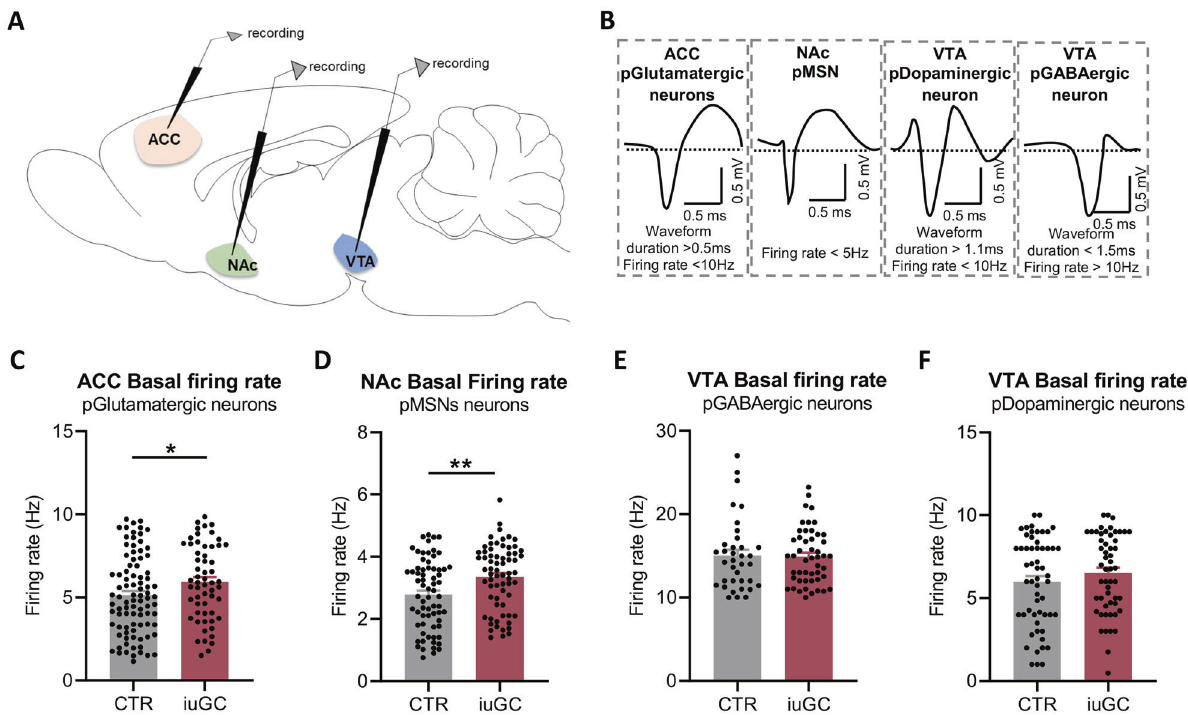
Fig. 3 iuGC exposure hampers neuronal basal activity of ACC and NAc. A Schematic representation of electrophysiological recordings of ACC, NAc, and VTA. B ACC neurons were separated according to fi ring rate and waveform characteristics: putative glutamatergic neurons; NAc neurons were separated according to fi ring rate and waveform characteristics putative medium spiny neurons (pMSNs); VTA neurons were classi fi ed as: putative dopaminergic neurons or putative GABAergic neurons. C The basal fi ring rate of the ACC is signi fi cantly different between groups, with iuGC rats presenting a hyperactivation of putative glutamatergic neurons. n CTR = 4 animals/90 cells (12 – 32 cells/animal); n iuGC = 4 animals/58 cells (13 – 18 cells/animal). D iuGC group has an hyperactivation of putative MSNs of the NAc; n CTR = 4 animals/68 cells (8 – 16 cells/animal); n iuGC = 5 animals/67 cells (6 – 20 cells/animal). The basal activity of the VTA of E putative GABAergic ( n CTR = 4 animals/56 cells (2 – 12 cells/animal); n iuGC = 4 animals/54 cells (2 – 15 cells/animal)) and F putative dopaminergic neurons ( n CTR = 5 animals/36 cells (2 – 12 cells/animal); n iuGC = 5 animals/55 cells (2 – 12 cells/animal)) is similar between groups. Error bars denote SEM. * p ≤ 0.05; ** p ≤ CTR rats (t(39) = 2.719, p = 0.0097, Fig. 4D). During stimulation, the response was similar between groups (t(39) = 0.8095, p = 0.4231; Fig. 4D, Supplementary Fig. 5A). Cells that presented an inhibitory response during the stimulation period presented a higher fi ring rate in iuGC animals in comparison to CTR group (t(45) = 2.483, p = 0.0168; Fig. 4D).